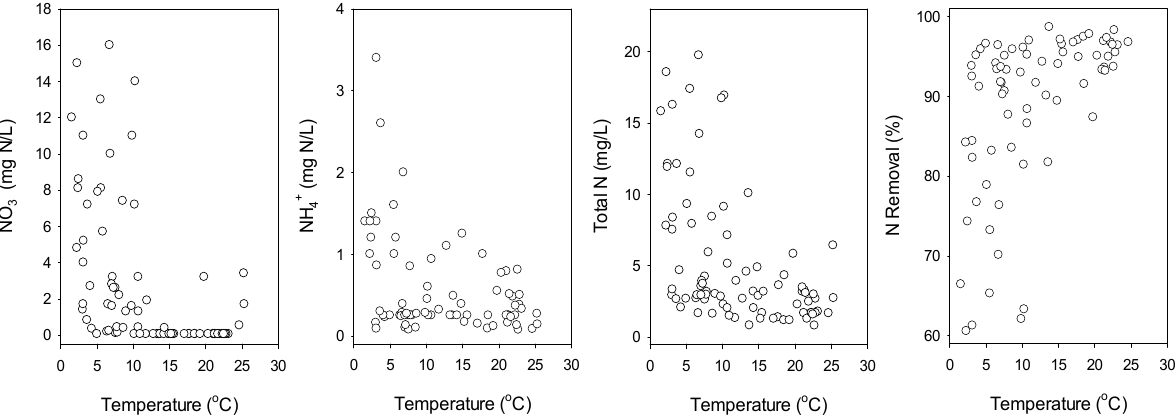
Figure 3. Relationship between % N removal, nitrate, ammonium, and total N concentration in effluent and temperature in the mesocosm.